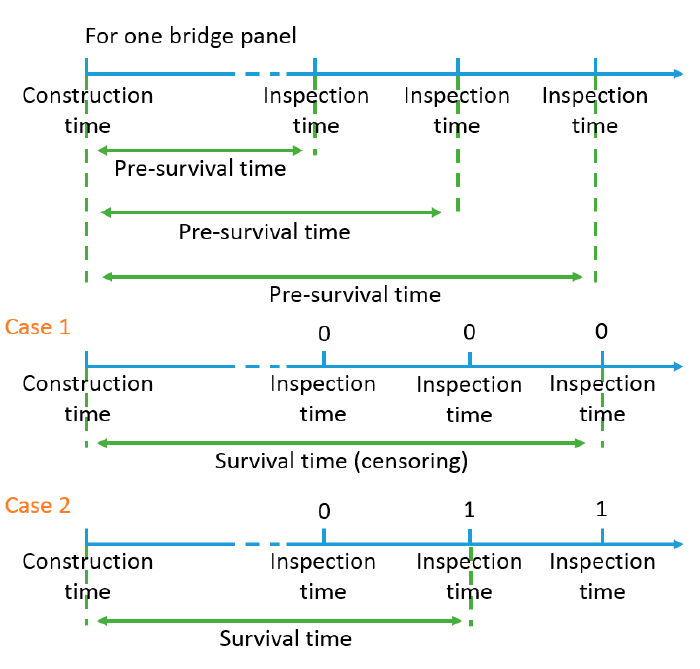
Figure 5. Calculation of survival time.